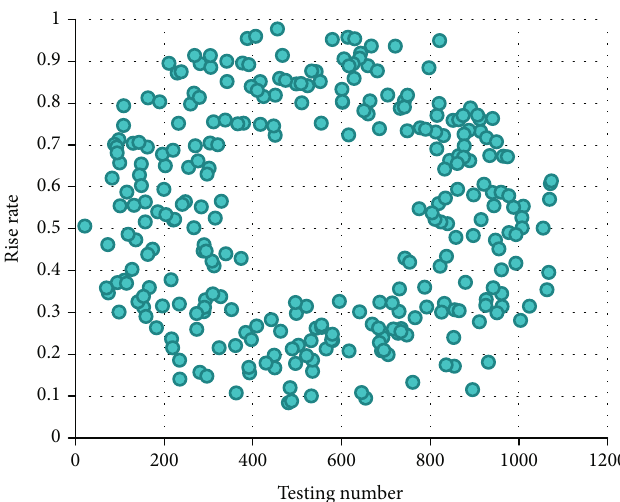
Figure 5: Scatter chart of class head-up rate in the fi rst class.